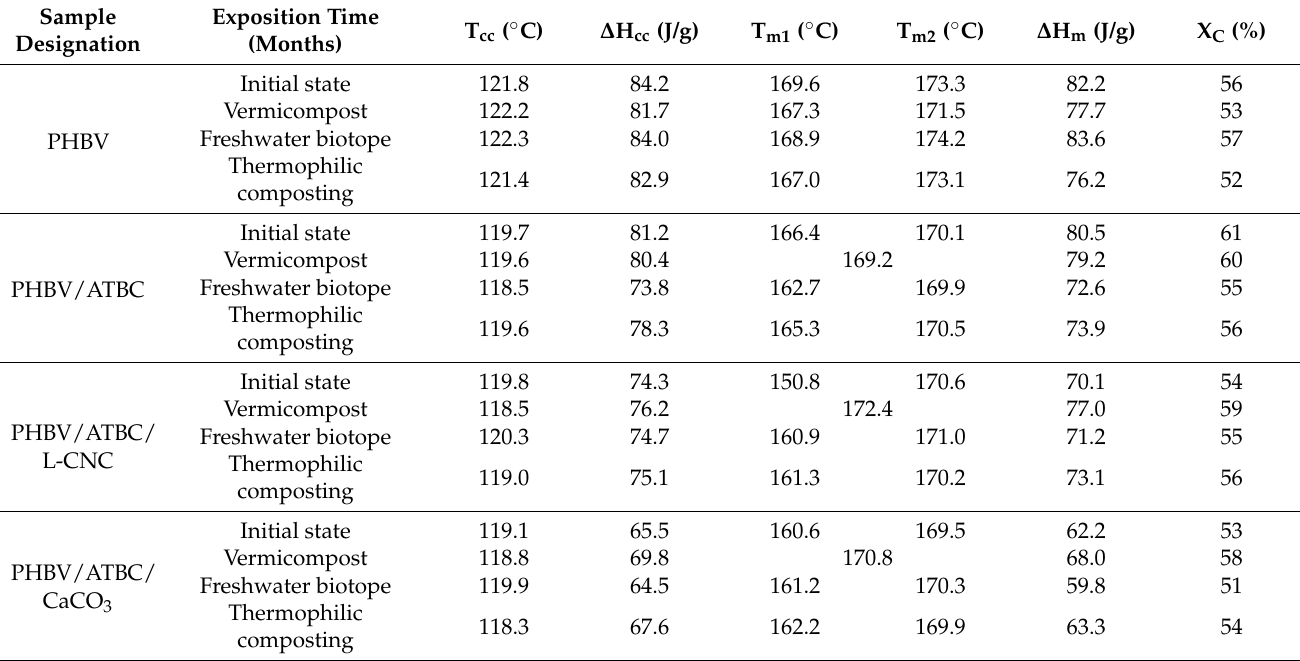
Table 4. Thermal analysis (DSC) data of PHBV bio-composites at initial state and after 30 days